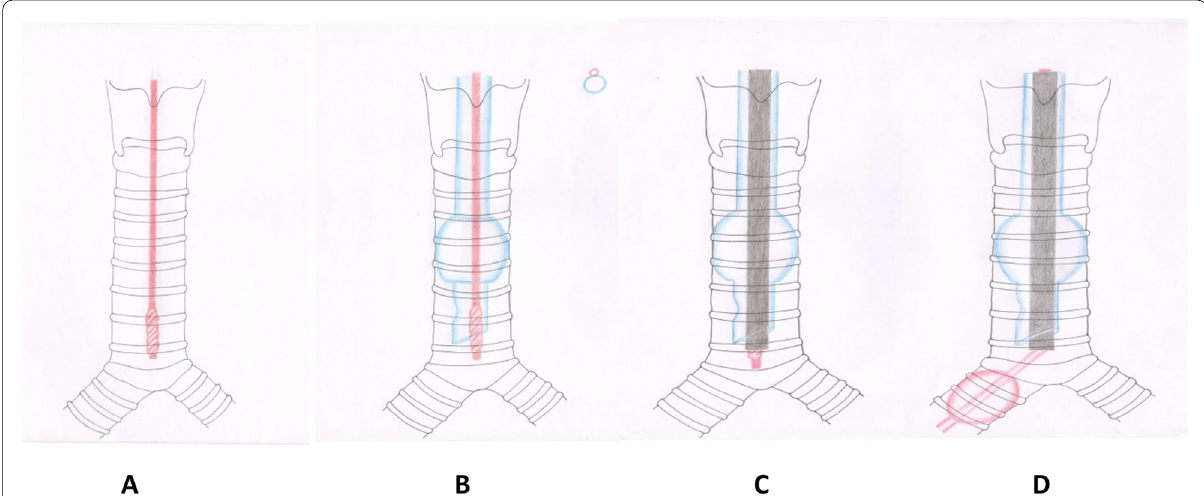
Fig. 1 Schematic diagram portraying use of embolectomy catheter (EC) for achieving lung isolation in pediatric patients. A Appropriately sized EC bent 30° at the tip is passed through glottis into trachea under direct vision by laryngoscopy. B Undersized cuffed ETT is then placed into the trachea, anterior to EC, until its black mark is below the glottis; its cuff is inflated with air and bilateral air entry confirmed. C A lubricated pediatric FOB is advanced through ETT beyond its tip to visualize the trachea, carina, and the tip of EC. D The cuff of ETT is deflated and the EC is maneuvered into the desired bronchus by applying torque its extra-oral part. Its guide wire is removed, and the cuff inflated under vision with air. Inflating volume is noted and thereafter ETT cuff is